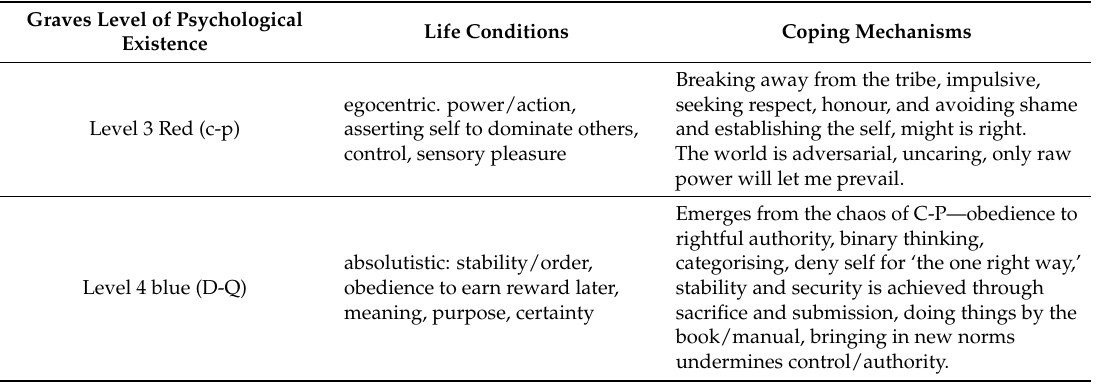
Table 1. Conditions and Coping Mechanisms utilised at each level of Psychological Existence. Graves Level of Psychological